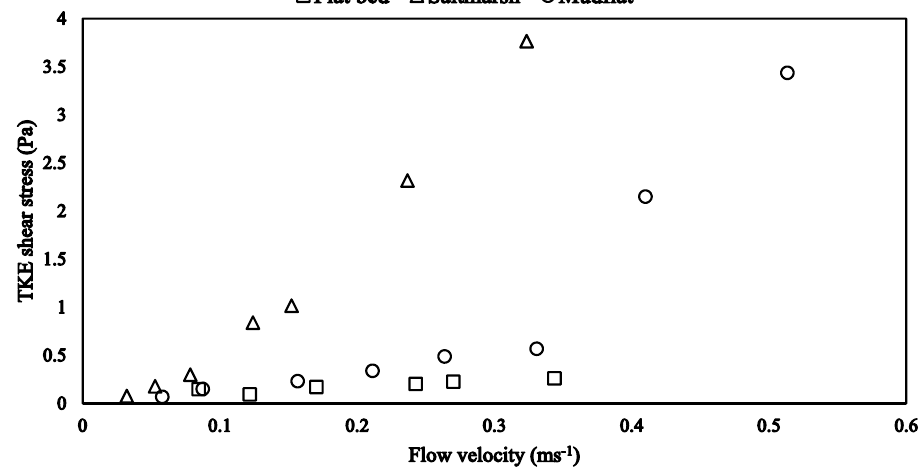
Figure 2. Mean flow velocity and TKE shear stress distributions for the three experimental runs; Test A (flatbed clear water), Test B (mudflat/flat sediment bed) and Test C (saltmarsh/vegetated sediment bed). Vertical distributions of the flow velocities and TKE shear stresses for the three experimental runs are presented in Figs. S1, S2 and S3.